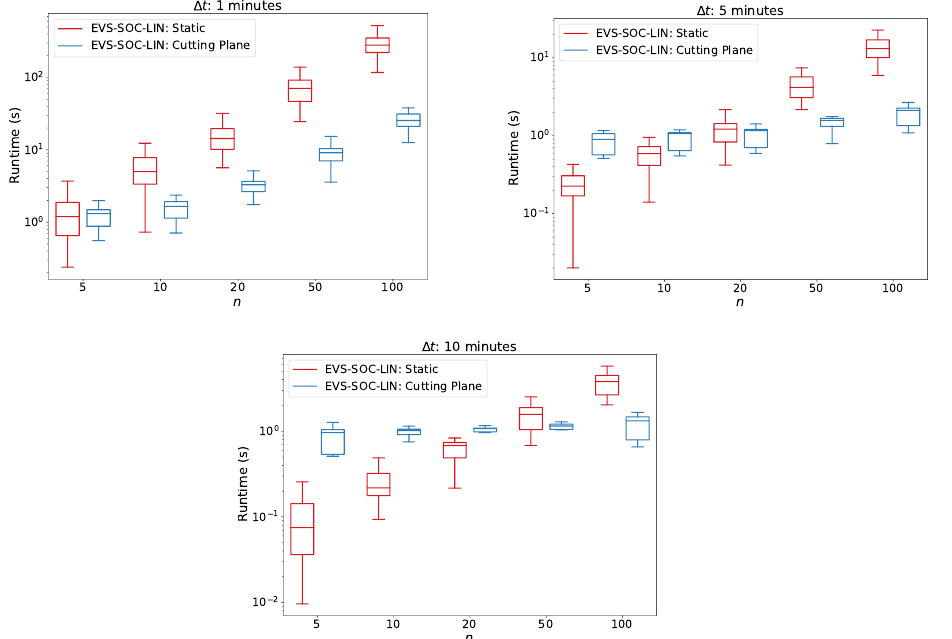
Figure 6. EVS-SOC-LIN runtime comparison for directly solving the LP problem versus the cutting plane approach corresponding to the results of Table